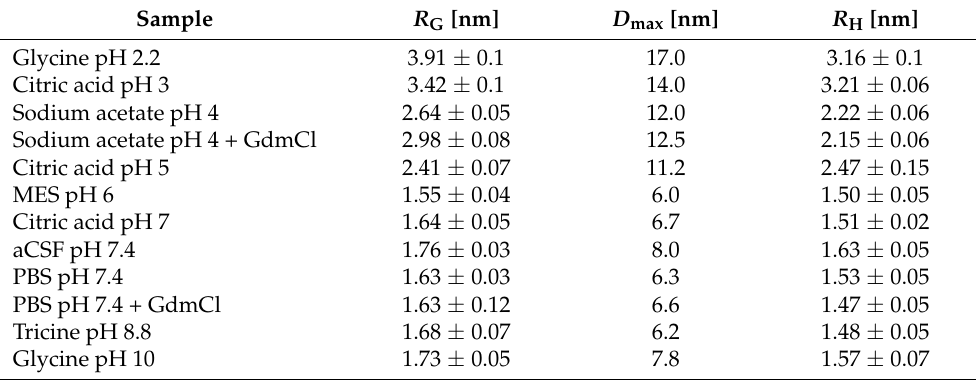
Table 1. The structural parameters characterizing HCC in different conditions. The radii of gyration ( R G ) and the size of the molecule D max were calculated from the SAXS data and the hydrodynamic radii ( R H ) from the DLS results.